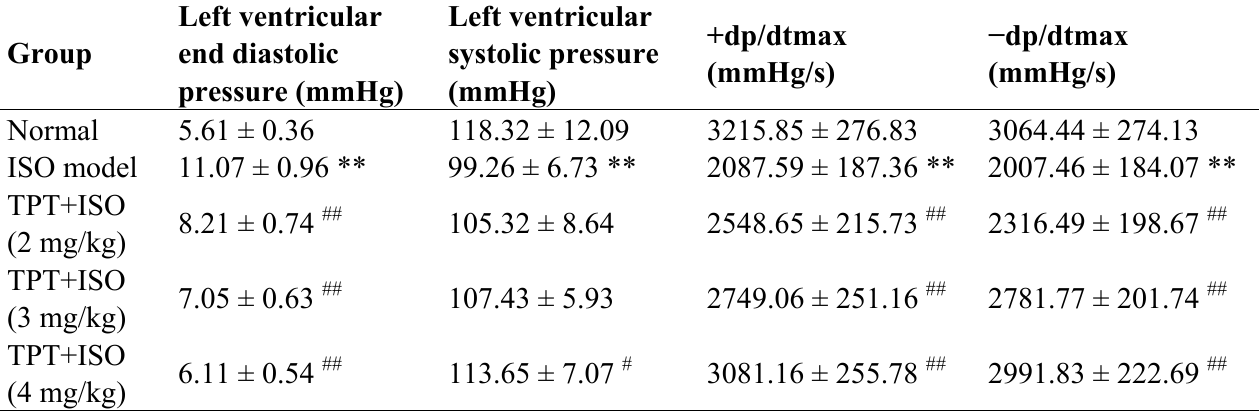
Table 1. Effect of TPT on LVEDP, LVSP, +dp/dtmax, and − dp/dtmax in all groups of rats.